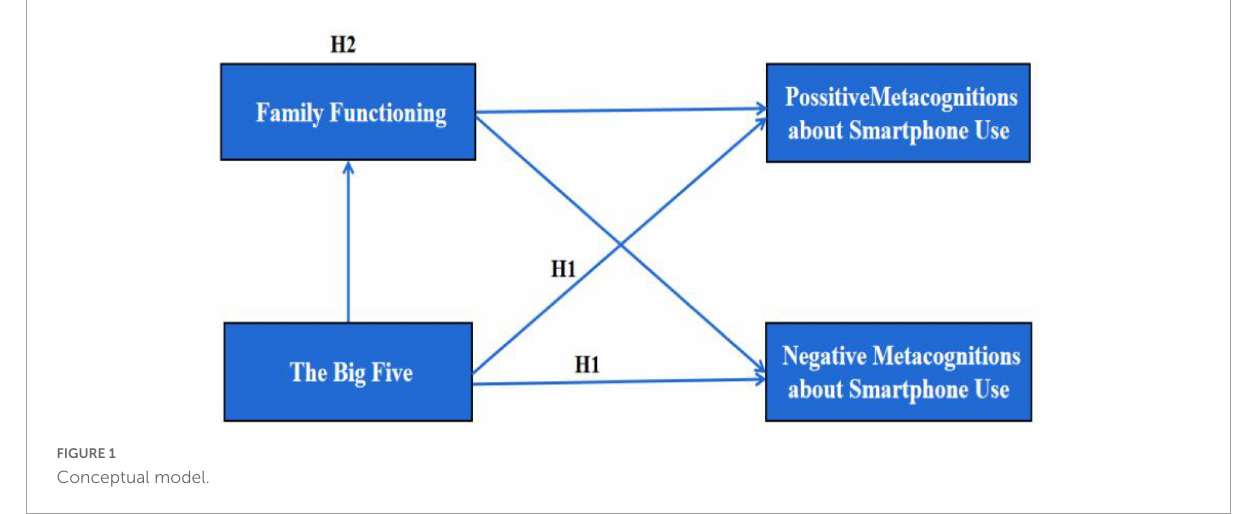
FIGURE1 Conceptual